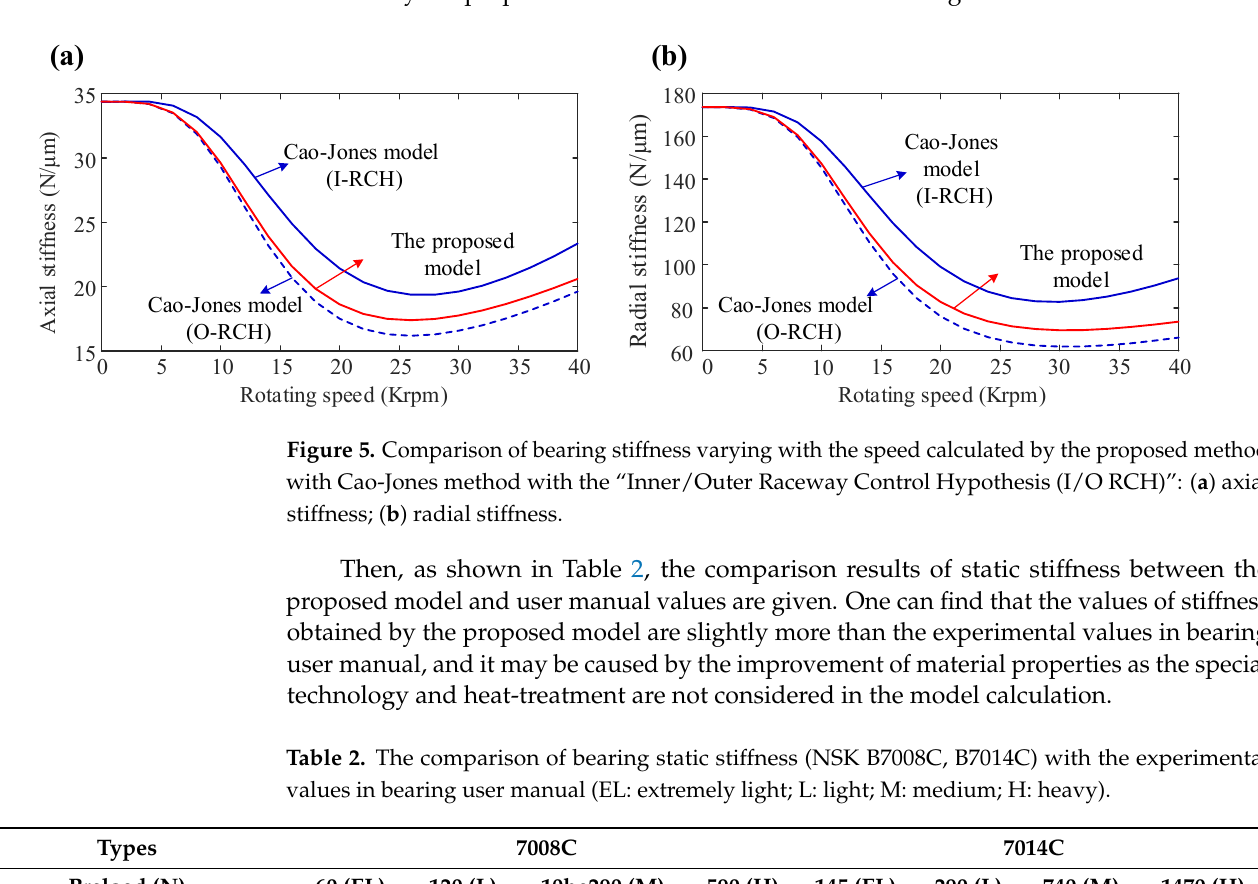
Table 2. The comparison of bearing static stiffness (NSK B7008C, B7014C) with the